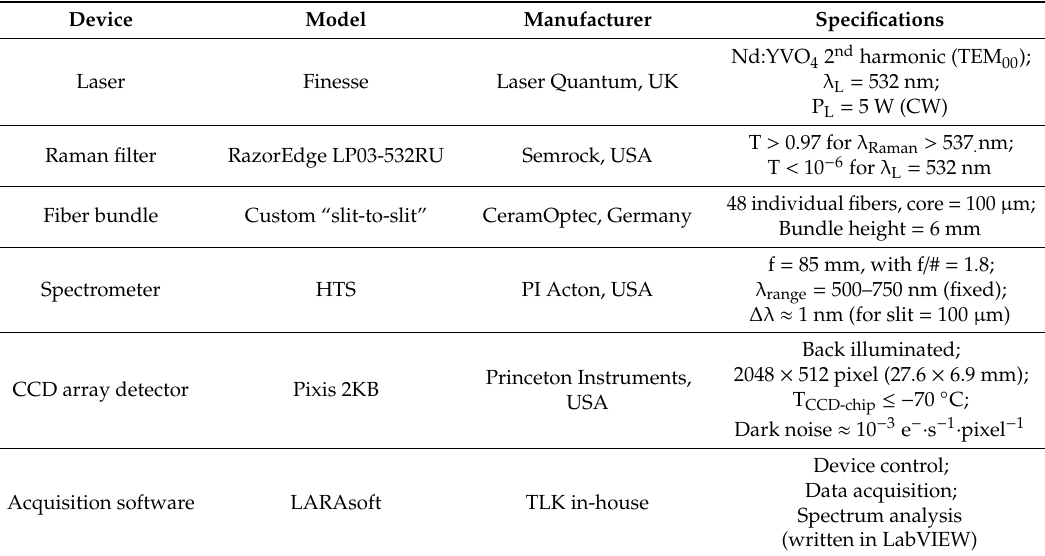
Table 1. Equipment modules used in the KATRIN LARA setup, and their